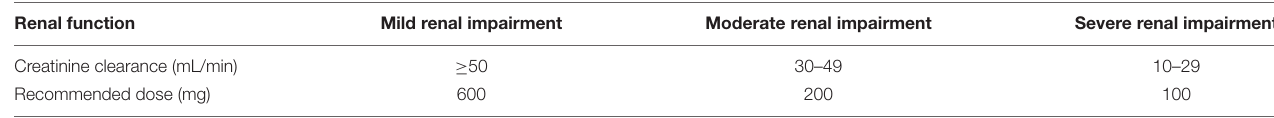
TABLE 2 | Dosage adjustment for patients with altered creatinine clearance. Renal